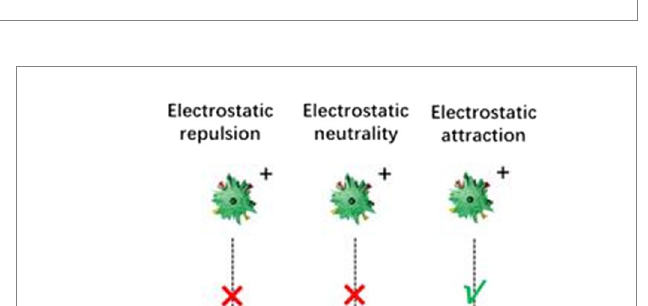
FIGURE 4 Structural modifications for covalent binding reactions of polymer precursors (77).